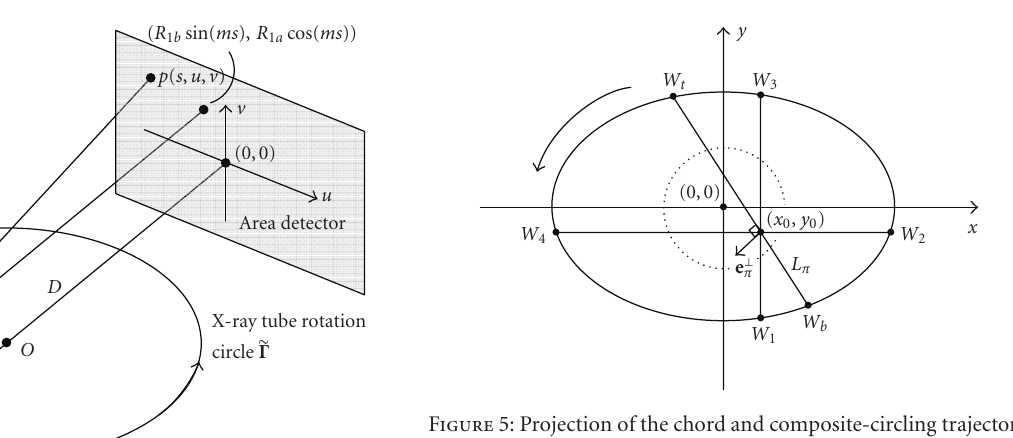
Figure 5: Projection of the chord and composite-circling trajectory on the x - y